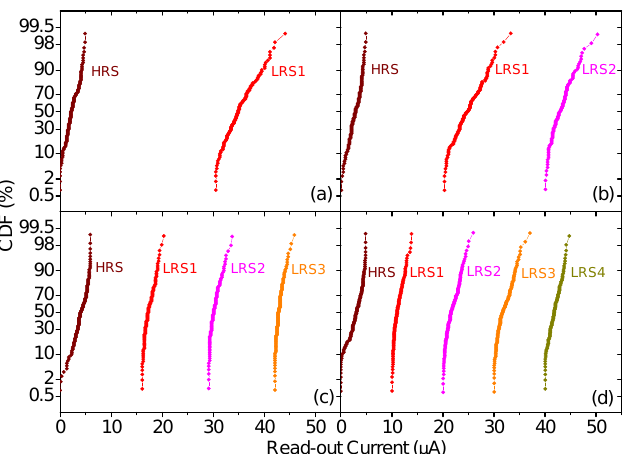
Figure 2. Cumulative distribution functions (CDFs) of the read-out currents measured for each set of conductive levels, namely, 2 levels ( a ), 3 levels ( b ), 4 levels ( c ), and 5 levels ( d ). The conductance levels were obtained by means of the Multilevel Incremental Step Pulse with Verify Algorithm (M-ISPVA) algorithm [35]. LRS stands for low resistance state, this means that the memristors have a low internal resistance value, and HRS stands for high resistance state. These current levels, and therefore, the device conductance, are obtained by means of different sets of algorithm parameters. In this respect, the corresponding neural network weight quantization strategies can be linked to the algorithms chosen to electrically operate the devices.